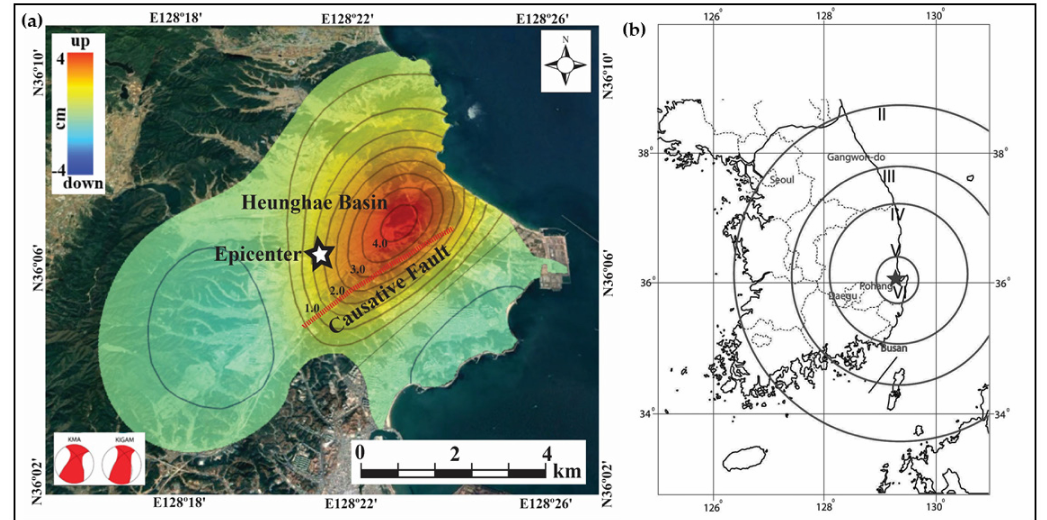
Figure 2. InSAR data showing ( a ) the deformation caused by the Pohang earthquake along with the causative fault for the earthquake; ( b ) Modified Mercalli intensity scale (MM) map (source: https: // earthquake.usgs.gov / earthquakes / eventpage / us2000bnrs / executive; last assessed: 15 October 2020) showing the intensity distribution for the Pohang earthquake (InSAR data are taken from http: // sar.kangwon.ac.kr /